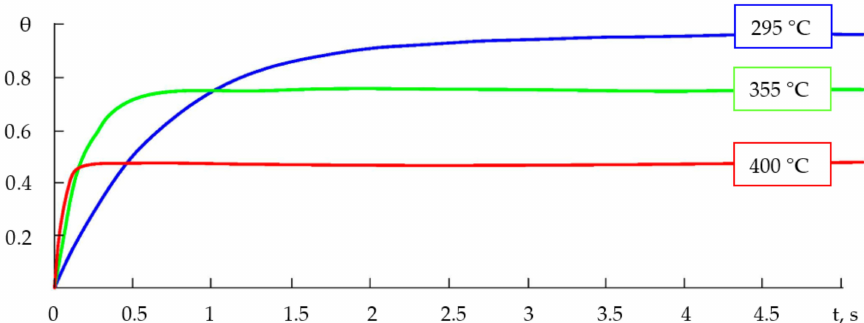
Figure 17. Typical dependencies of degree of filling on time (at different temperatures within Langmuir model).